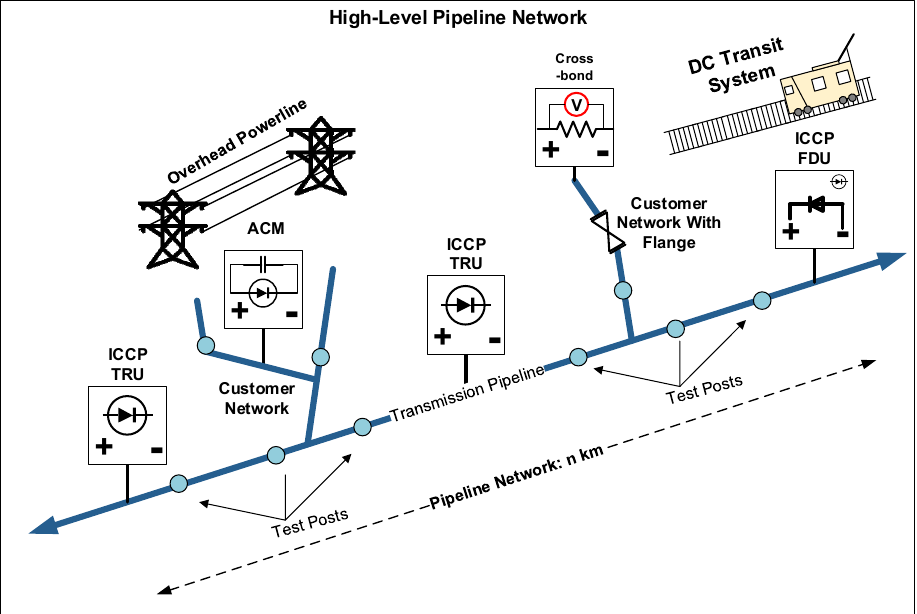
Figure 2. Typical CP system elements. Source: adapted from [12,38–40].